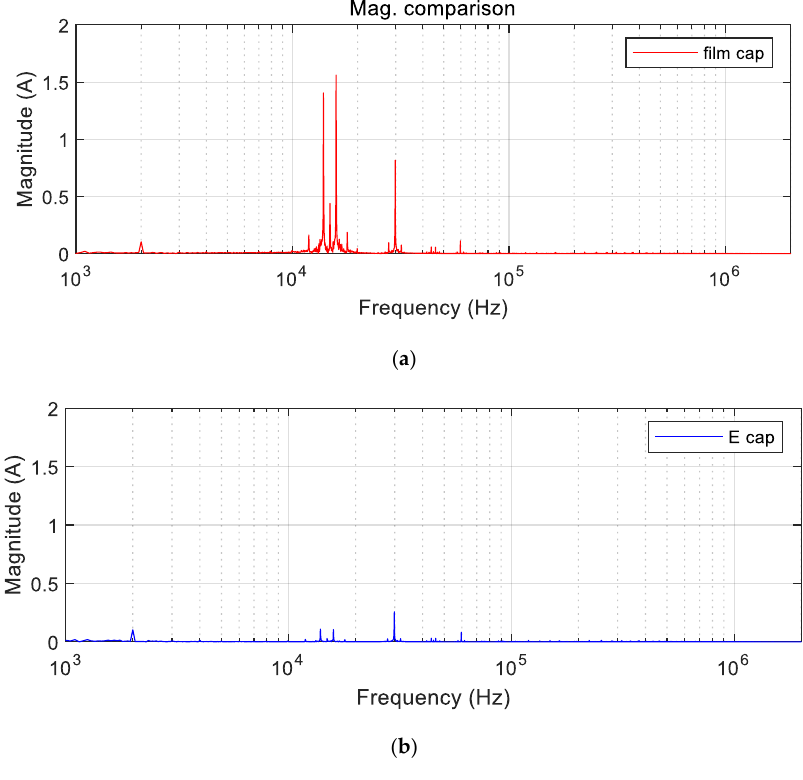
Figure 14. Magnitude of DC-link currents of VSI with film ( a ) and electrolytic ( b ) capacitors as functions of frequency. At motor speed = 5000 rpm and phase current amplitude = 10 A.